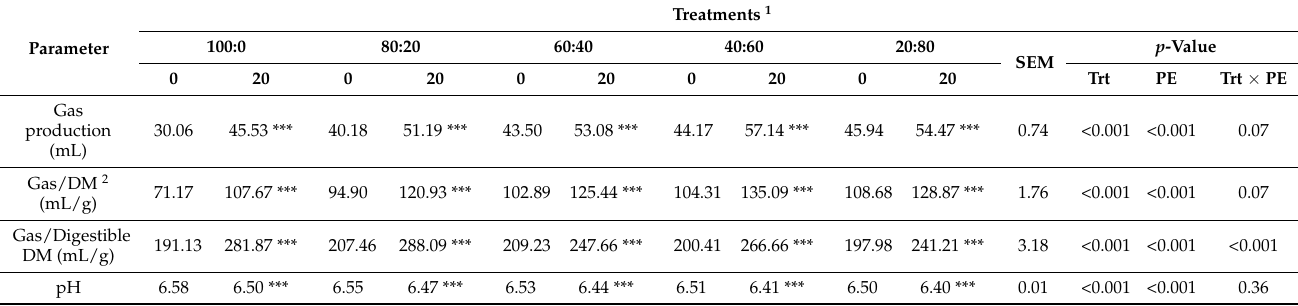
Table 2. Effect of plant-bioactives extract (PE) supplementation on gas production and pH in different feeding styles after 24 h In Vitro incubation ( n =